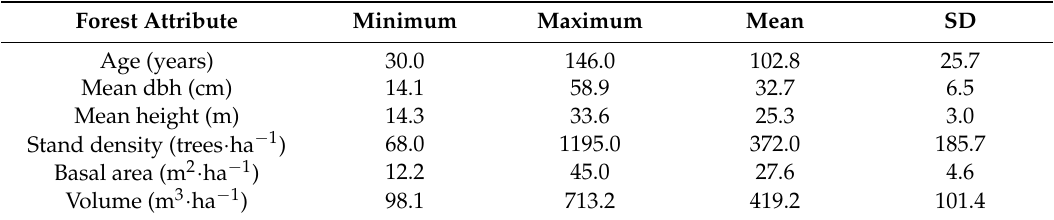
Table 2. Descriptive statistics of the stand-level forest attributes for 548 selected even-aged pedunculate oak stands of Spaˇcva